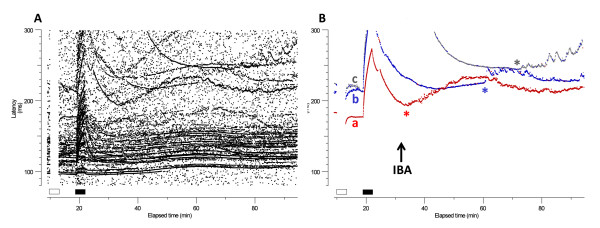
Activation of C-fibres by IBA. Raster plot of latencies and identification of single action potentials. A: Raster plot of latencies in the C-fiber range corresponding to several C fibers during baseline stimulation (0.25 Hz), pause (0 Hz, open bar) and tetanus (2 Hz, filled bar). Different fibers with particular activity-dependent profiles can be observed. B: Modified raster plot from A with extraction of 3 units of interest at latencies of 175, 215 and 220 ms during the period just before the 2 Hz stimulation (a, in red, CV = 0.45; b, in blue, CV = 0.32 m/s; c, in grey, CV = 0.31 m/s; CV: conduction velocity), for a better visualization. These three units displayed appreciable slowing (>2%) following the pause (open bar), and slowed more than 50% during the 2 Hz tetanus (units b and c slow beyond the 300 ms latency limit of the recorded signal), indicating they were Type 1B mechano-insensitive C-nociceptors [40]. Injection of IBA (1%, 2 μl) s.c. induced persistent ongoing discharges in all three mechano-insensitive C-nociceptors, giving rise to jittery baselines with a "saw-tooth" profile, lasting many minutes (>30 min for unit a). Onset of action was different for the three units (marked with a colored asterisk).